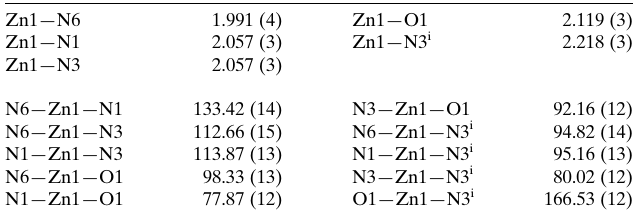
Table 1 Selected geometric parameters (A˚ , (cid:5)